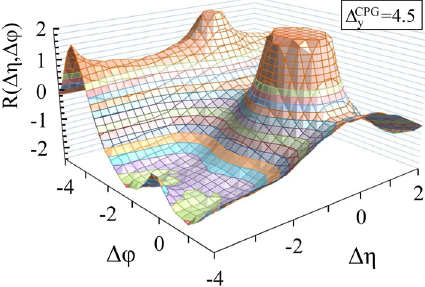
Fig. 6 The R (Δη,Δϕ) distribution simulated with FANSY 2.0 CPG (“moderate”) at | Δη | ≤ 4 for high-multiplicity events